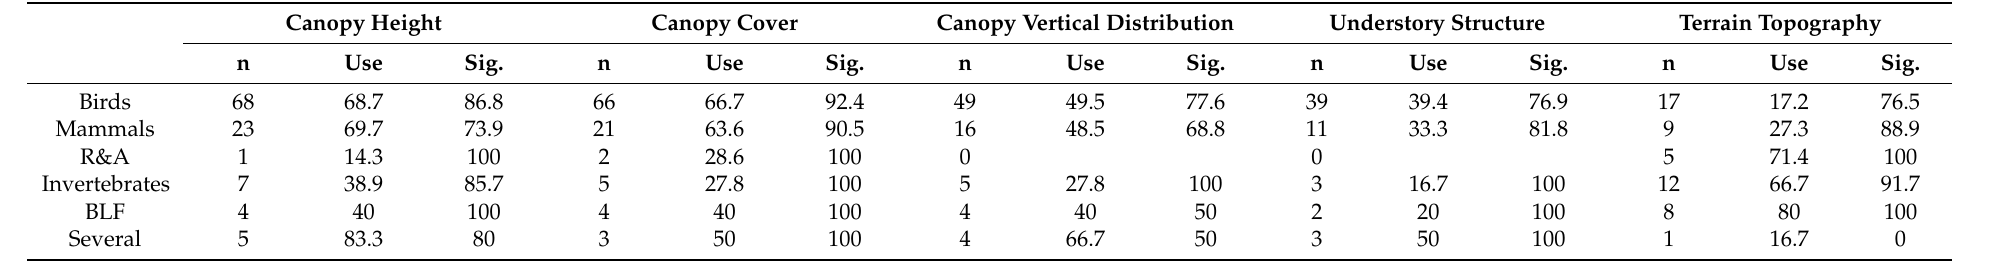
Table 2. Categorized LiDAR-derived traits based on all metrics found in the literature search regarding vegetation structure and terrain topography in relation to the studied taxonomic groups. “n” represents the number of studies of each taxonomic group in which a variable regarding the categorized traits was used; “use” is the percentage of articles of each taxonomic group that uses a given metric in relation to the whole articles of each taxonomic group. For example, if 68 of 99 of bird studies used canopy height, then the use was 68.7%. “sig.” is the ratio (%) between the number of articles in which a given metric has an effect in relation to the number of articles in which that metric is used. For example, in 59 of 68 bird articles in which canopy height was used, it had an effect = 86.76%. BLF: Bryophytes, lichens, and fungi; R&A: reptiles and amphibians; Several: studies including more than one taxonomic group.